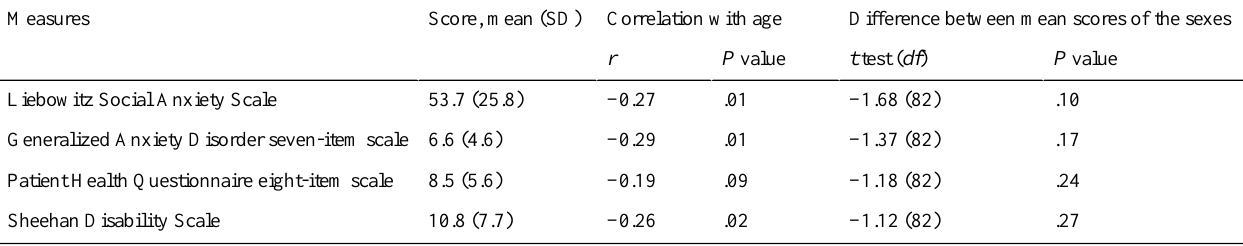
Difference between mean scores of the sexesCorrelation with ageScore, mean (SD)Measures